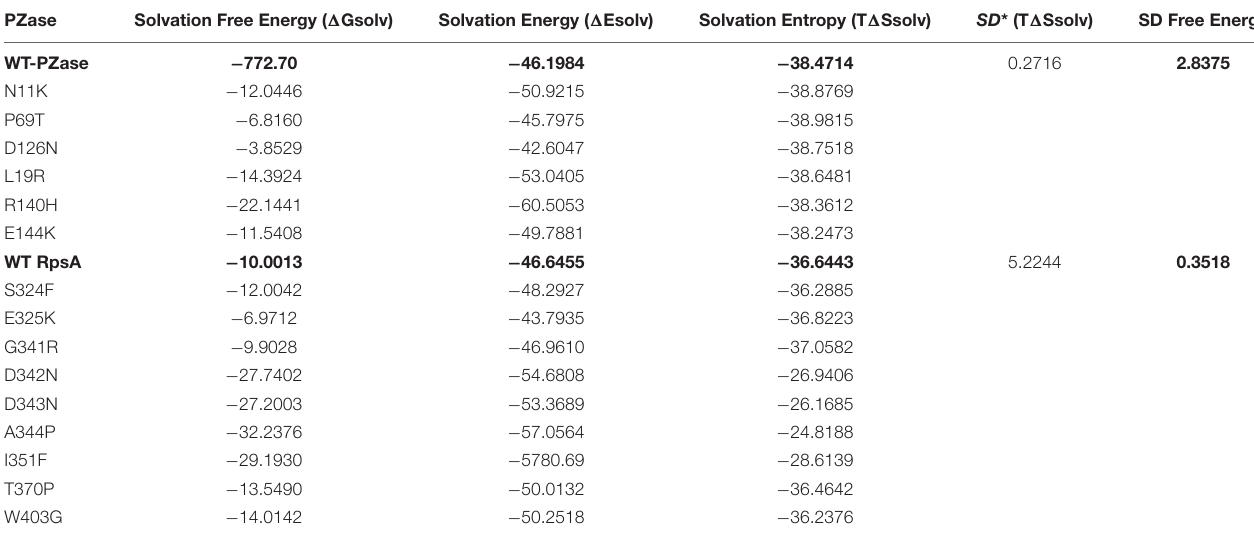
TABLE 2 | Comparison of solvation energies of wild types and mutants PZase and RpsA. PZase Solvation Free Energy ( (cid:49) Gsolv) Solvation Energy ( (cid:49) Esolv) Solvation Entropy (T (cid:49)